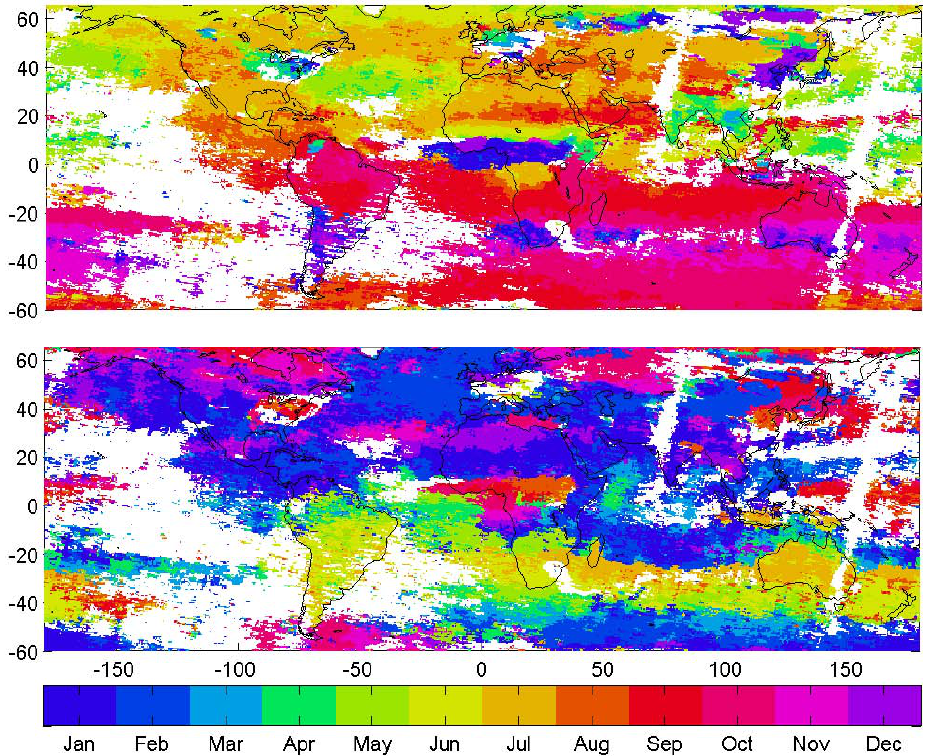
Fig. 5. Month with (a) maximum and (b) minimum TVCD. Only data of p-values less than 0.001 are